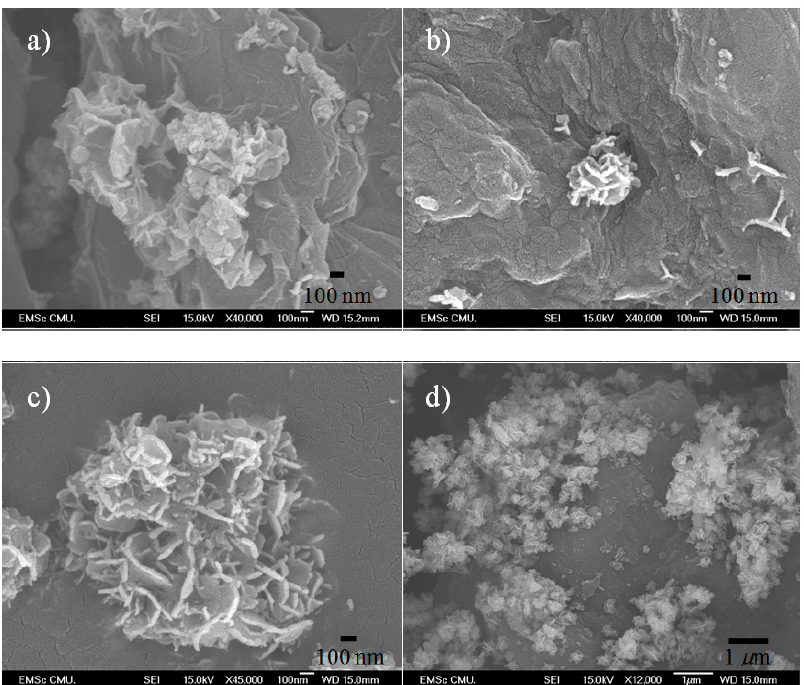
Figure 1. The field emission scanning electron microscope (FESEM) images of the new as prepared samples, before lithiation: ( a ) the 10SnS/artificial graphite (AG) composite; ( b ) the 10SnS/multicarbon–microbeats (MCMB) composite; ( c ) the 20SnS/AG composite; ( d ) the 20SnS/MCMB composite. Table 1. FESEM–electron dispersive spectroscopy (EDS) analysis conducted before cycling to deter- mine the content and particle size of Sn and